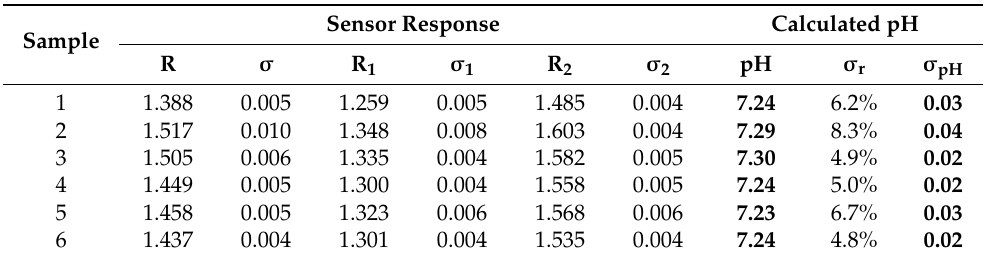
Table 1. Overview of the sensor response and calculated pH values ( σ -standard deviation; σ r -relative standard deviation).